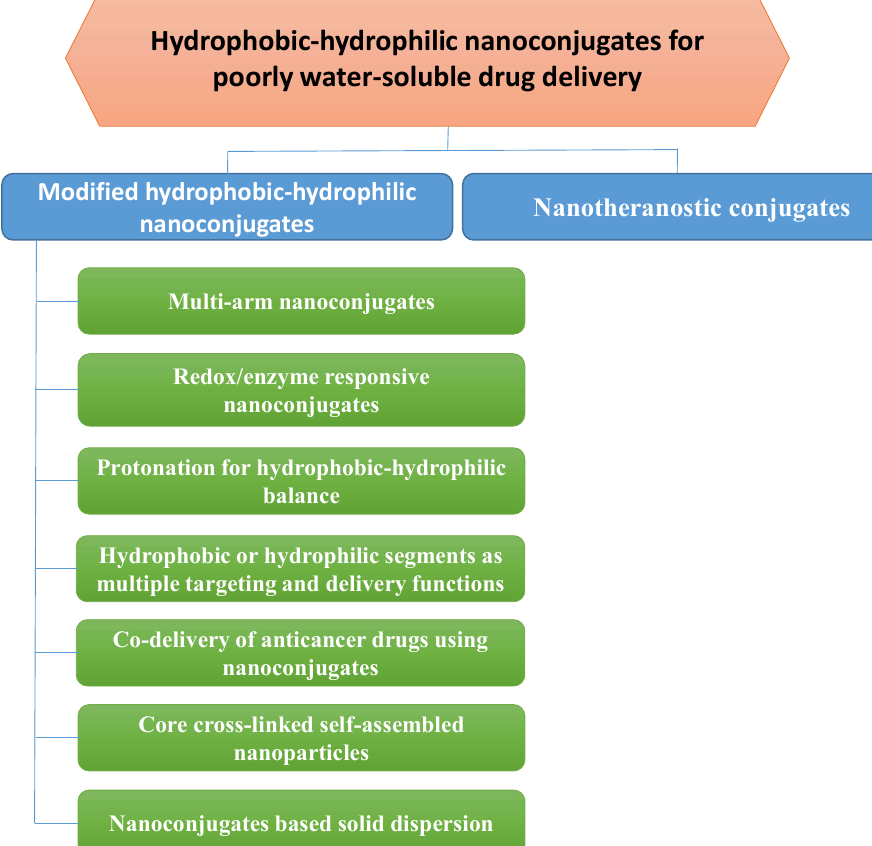
Figure 1. Illustration of nanoconjugation for improving drug delivery and therapeutic efficacy of poorly water-soluble drugs.